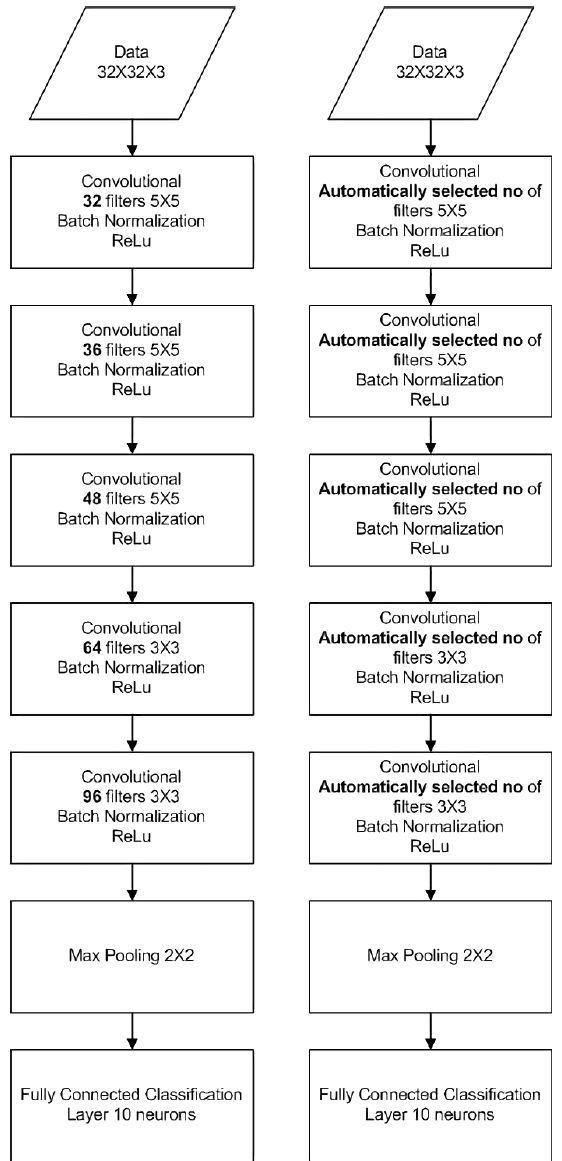
Figure 15. Vanilla CNN for CIFAR10 classification ( left ), Adaptive CNN for CIFAR10 classifica- tion ( right ).